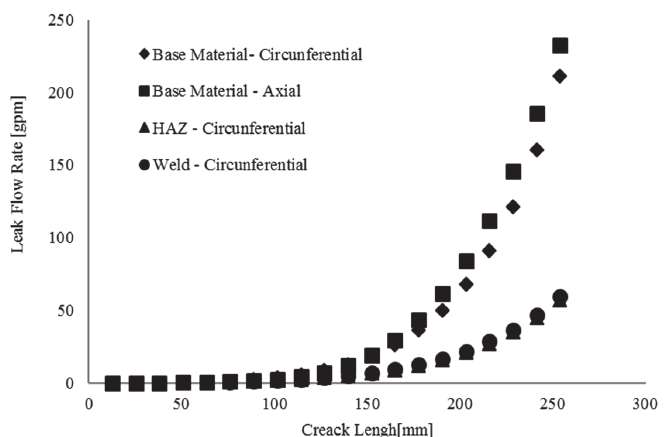
Figure 3: Typical Leak flow rate x crack length for different zones in welded pipe.